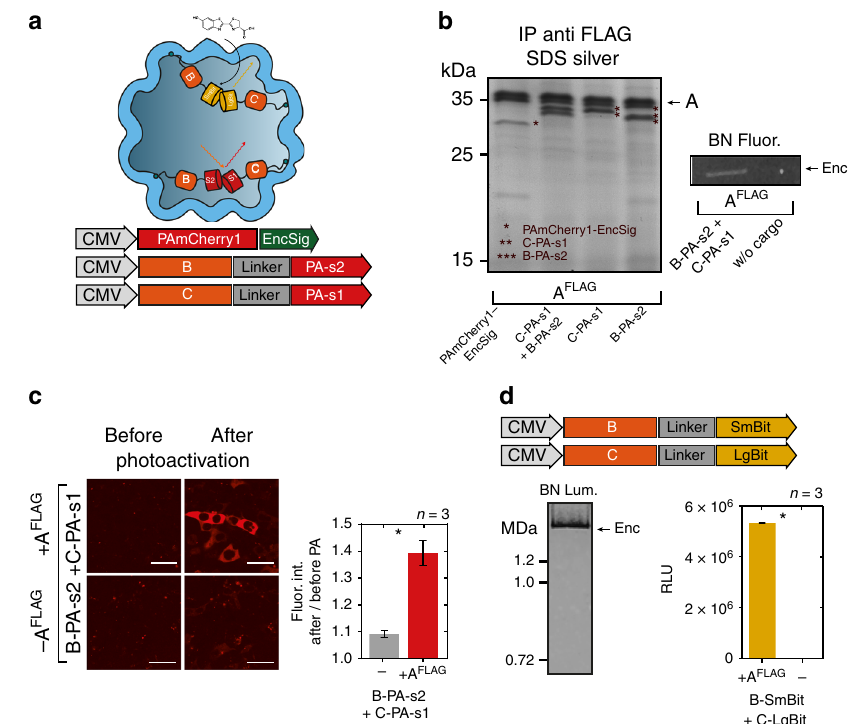
Fig. 4 Multi-component processes and enzymatic reactions can be targeted to encapsulins in mammalian cells. a Overview schematic of sets of cargo molecules for bimolecular fl uorescence and enzyme complementation inside the nanocompartment. Targeting of foreign cargo proteins can be achieved either via a minimal C-terminal encapsulation signal (EncSig) or via C ‑ terminal fusions to the native cargo proteins B, C, or D. b Silver-stained SDS-PAGE from a co-immunoprecipitation (Co-IP) of A FLAG co-expressed with photoactivatable mCherry1 with EncSig (PAmCherry1-EncSig) or with either one of the halves of split PAmCherry1 fused to C or B, or a combination of both (C-PA-s1 + B-PA-s2). Fluorescence originating from complemented split PAmCherry1 inside the encapsulins was detected on BN-PAGE loaded with whole cell lysates of cells expressing A FLAG and C-PA-s1 + B-PA-s2 after 2 min of photoactivation (PA) on an UV imager. c Live cell confocal microscopy images (scale bar represents 20 µ m) of HEK293T cells expressing B-PAs1 and C- PAs2 with or without the shell-protein A FLAG before and after 60 s of photoactivation (PA) with 405 nm (upper panel) demonstrating ef fi cient bimolecular fl uorescence complementation inside encapsulin compartments. Fluorescence of photoactivated split PAmCherry1 was excited using a 561 nm laser. Fluorescence signals of the sample without and with A FLAG were quanti fi ed by calculating the ratio of the mean signal after PA divided by the signal before PA. The bars in the lower panel represent the mean fl uorescence intensity ratios averaged over independent transfection experiments ± SEM ( p = 0.0123, unpaired t -test, n = 3). d Luminescence signal from BN-PAGE incubated with luciferase substrate and loaded with whole cell lysates of HEK293T co- expressing split luciferase fragments fused to either B or C (B-SmBit, C-LgBit) and A FLAG (left panel). The luminescent band corresponds to the complemented split luciferase inside the assembled nanocompartment. The bar graph (right panel) shows the corresponding total luminescence signals from the cell lysates expressing B-SmBit and C-LgBit with or without A FLAG , (mean ± SEM across three independent transfection experiments, in each experiment three technical replicates were averaged, p < 0.0001, unpaired t -test, n =